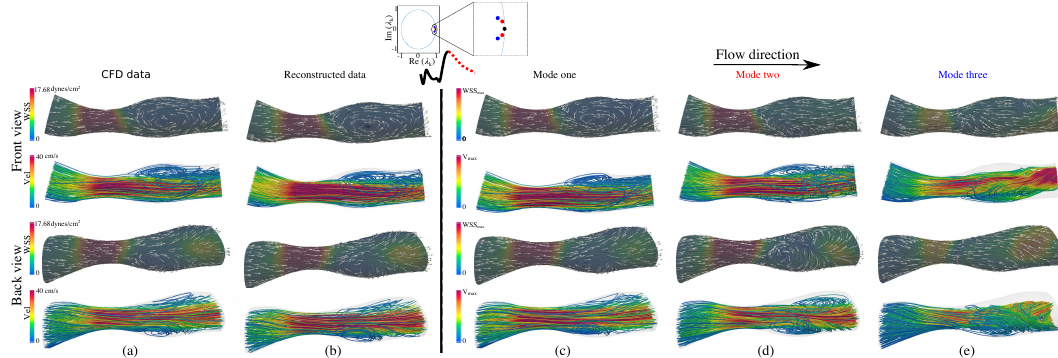
Figure 7. Velocity and WSS CFD data and the mDMDc modes are shown in the third stage of the coronary artery stenosis model. The stage is highlighted with a red dashed line in the flow waveform. The location of discrete eigenvalues in the unit circle corresponding to the selected mDMDc modes are shown. Velocity and WSS streamlines are shown and colored by their magnitude. WSS vectors are normalized and shown on top of the WSS streamlines to show the WSS vector direction. ( a ) CFD data (time = 0.8 s), ( b ) reconstructed data with 95% accuracy, ( c ) real part of the mDMDc mode corresponding to the eigenvalue λ = 1, ( d ) real part of the mDMDc mode corresponding to the eigenvalue λ = 0.98 ± 0.06, ( e ) real part of the mDMDc mode corresponding to the eigenvalue λ = 0.94 ± 0.09 i